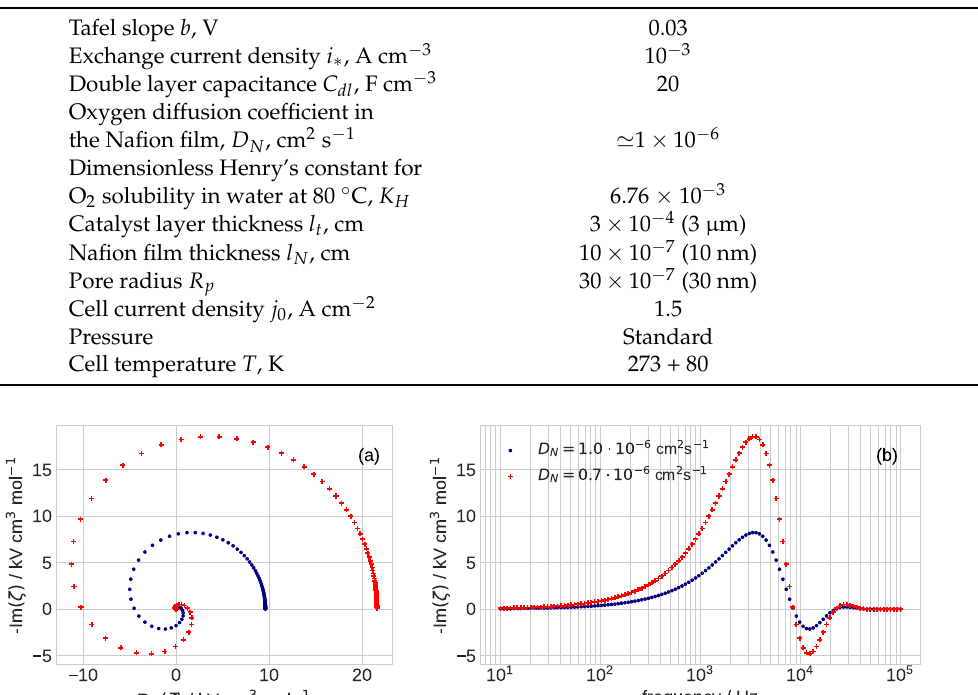
Table 1. The base-case cell parameters used in calculations.